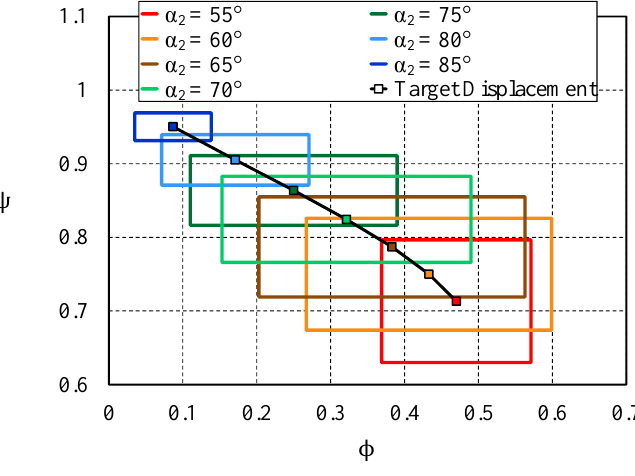
Figure 7. Target zones of preliminary design in a φ - ψ map, with reference to the stator outlet flow angle α 2